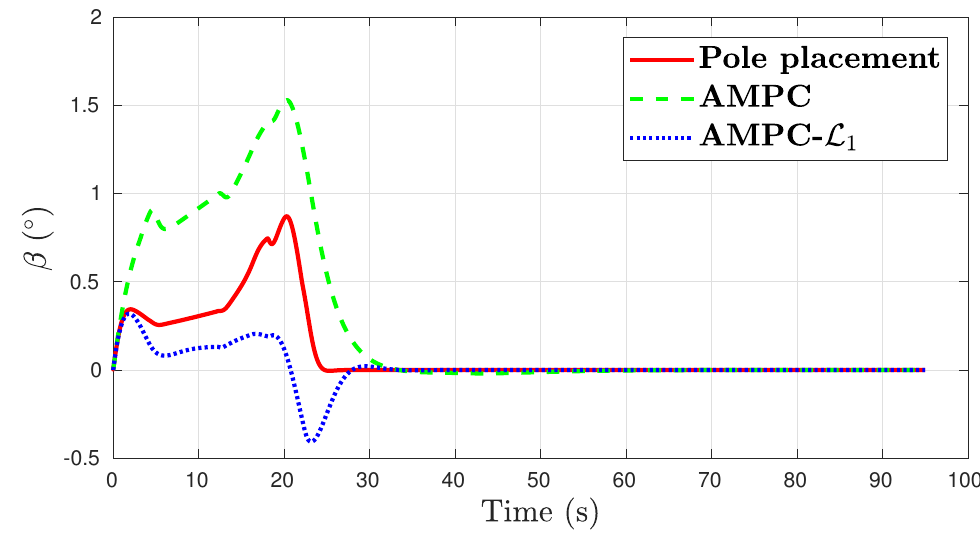
Figure 5. Sideslip regulation error for the nominal case.